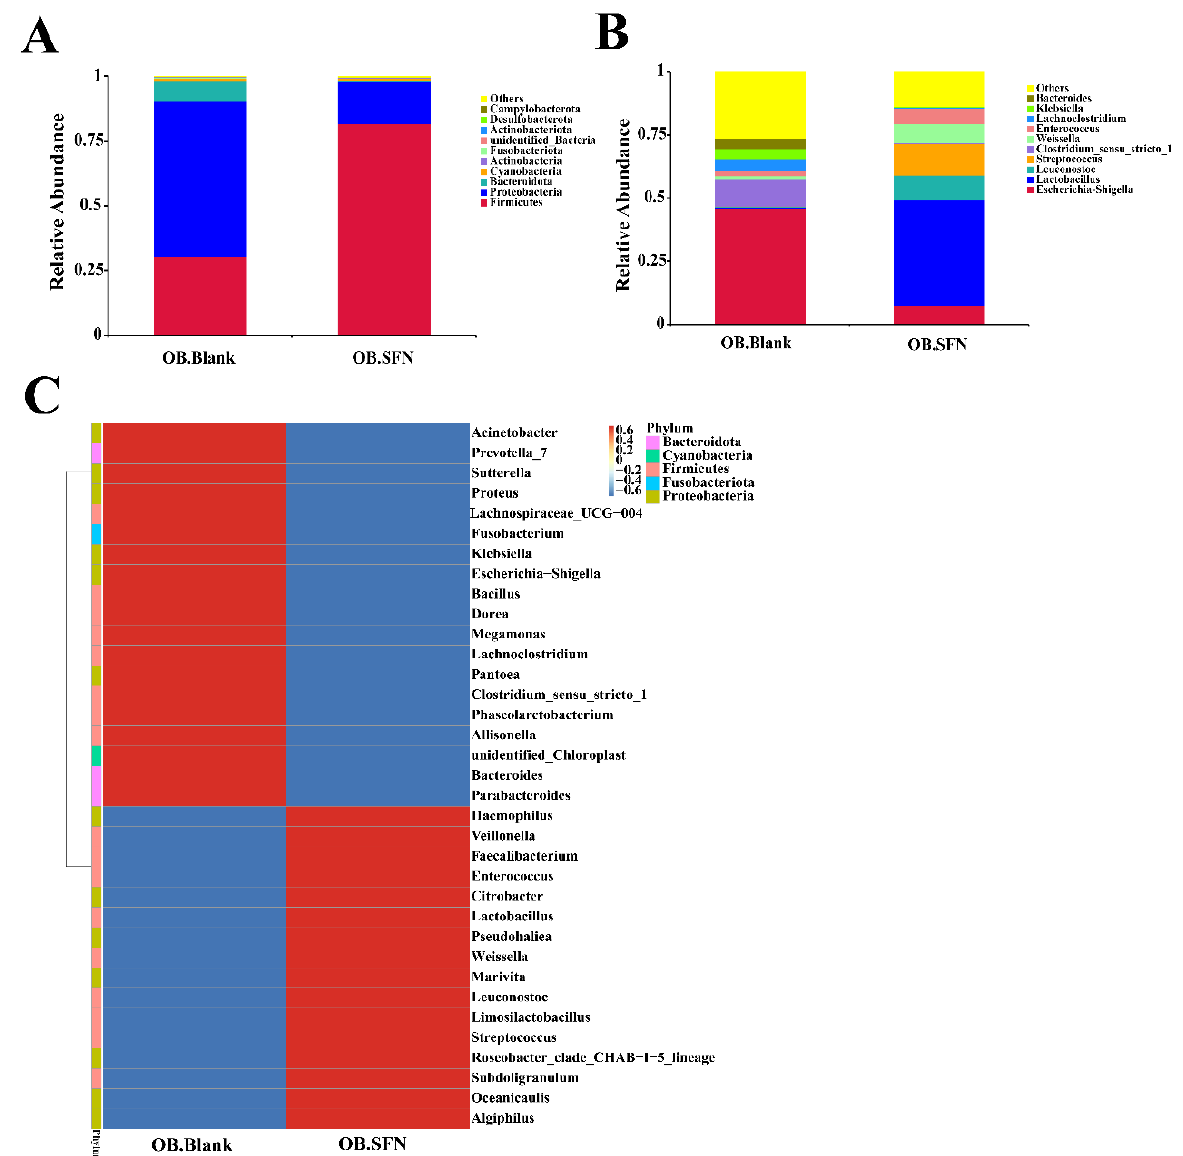
Figure 6. The effect of sulforaphane (SFN) on the gut microbiota in obese patients. ( A ) Gut microbial composition at phylum-level; ( B ) gut microbial composition at genus-level; ( C ) heatmap of gut microbial composition at genus-level.